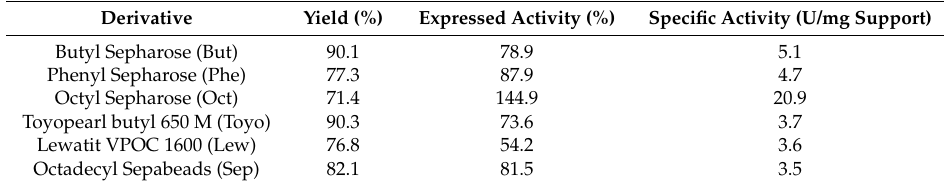
Table 1. Immobilization of Penicillium sp. (CBMAI 1583) lipase on hydrophobic supports. Derivative Yield (%) Expressed Activity (%) Specific Activity (U/mg Support) Butyl Sepharose